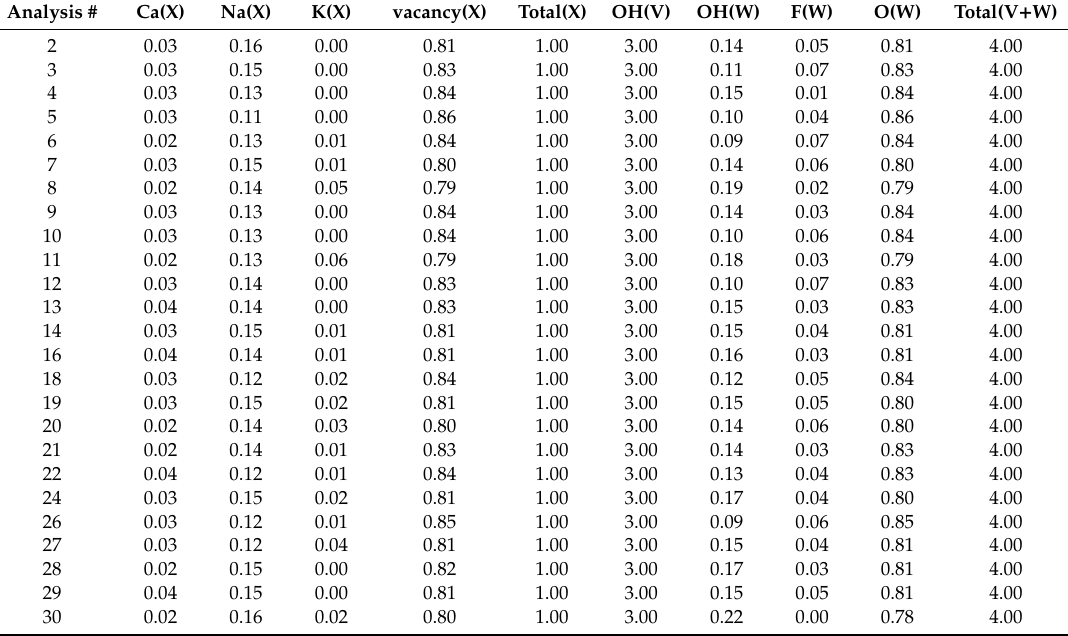
Table3. Structuralformulaof tourmalineT1(X, VandWsites) calculatedwiththe